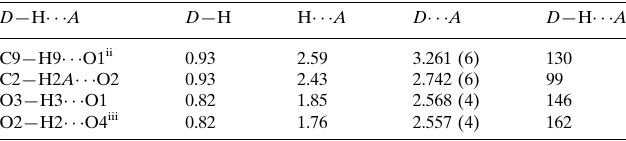
Hydrogen-bond geometry (A˚ , (cid:3)